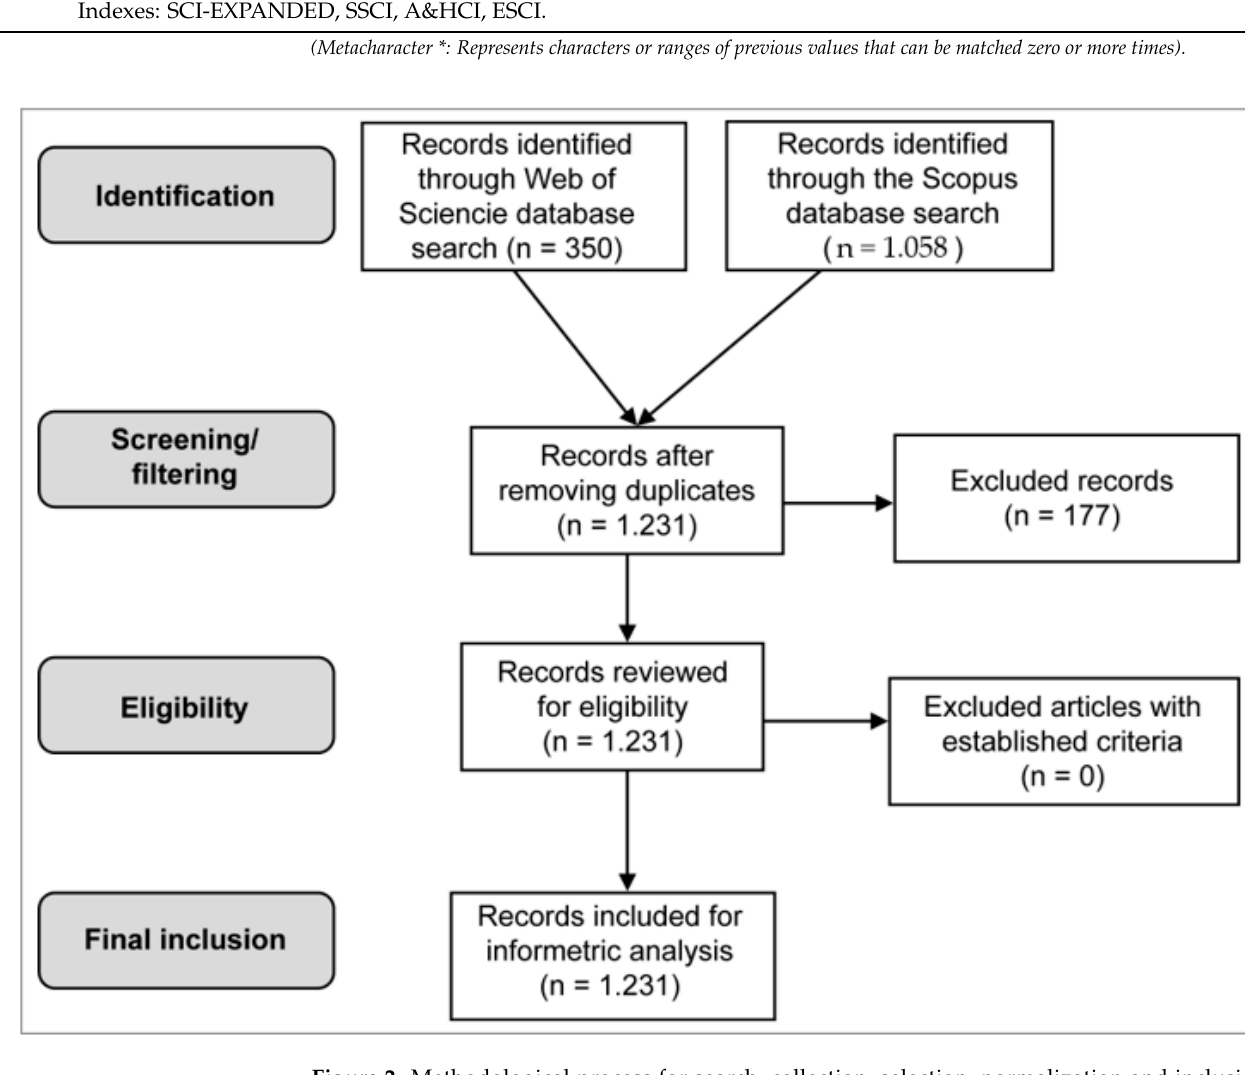
Figure 2. Methodological process for search, collection, selection, normalization and inclusion of records for the study.